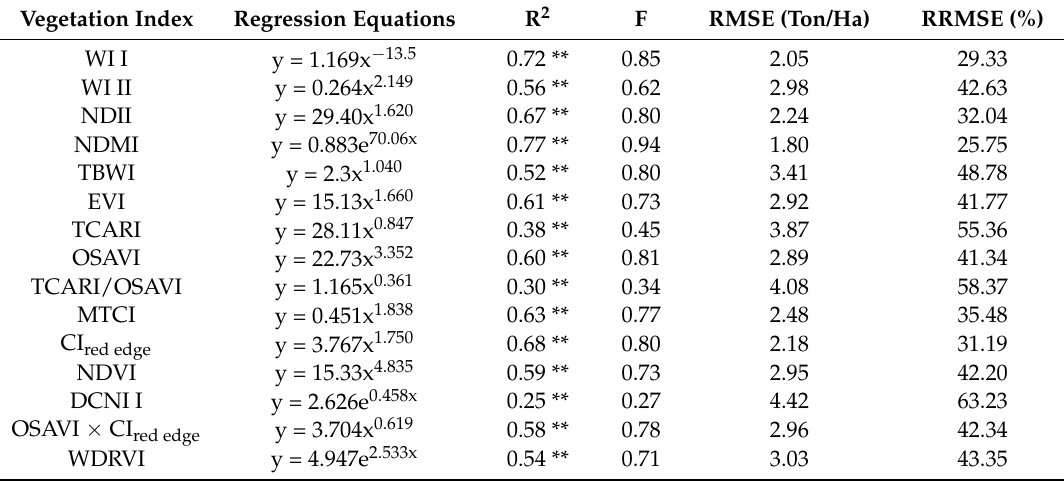
Table 5. Correlations between biomass and spectral indices of winter wheat ( n =